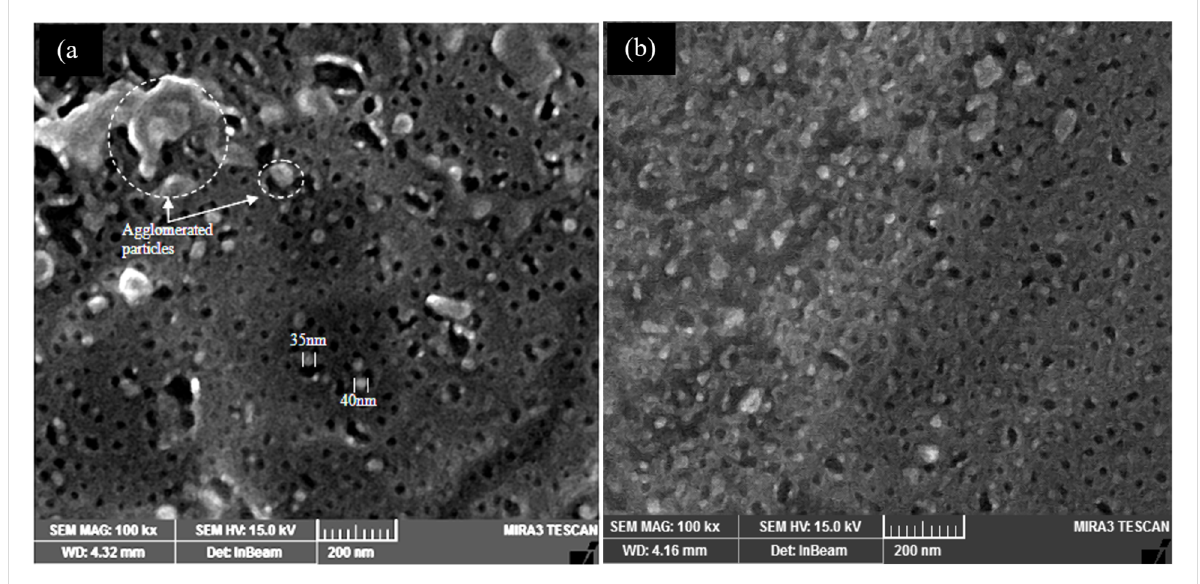
Figure 8: SEM images of Ag 2 S NPs synthesized in pure Tu solution (a) and Tu with CTAB surfactant solution (b).